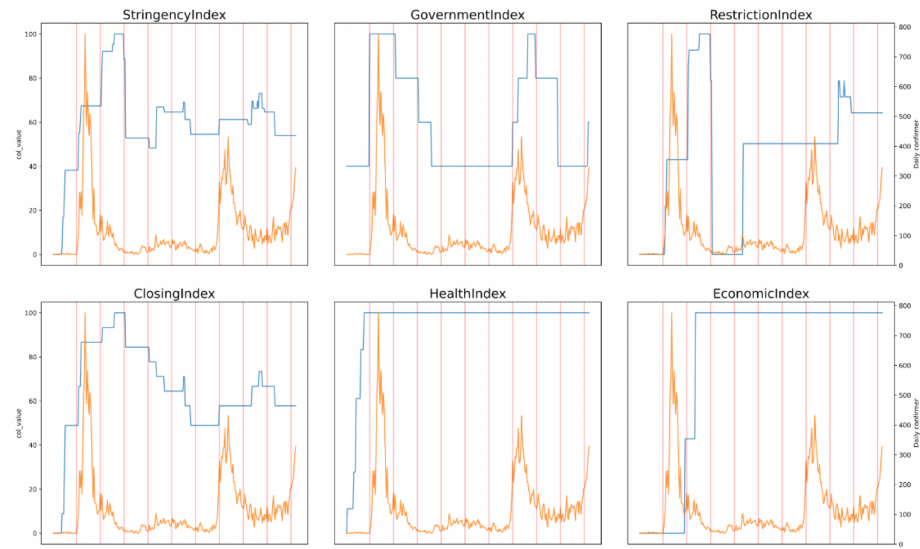
Figure 2. Variation of Indices with Daily Confirmed Cases Over Time (days). The blue line indicates the index’s level and orange line indicates the COVID-19 daily confirmed cases of South Korea. Each vertical red line represents 30 days difference at x-axis, approximately a month.